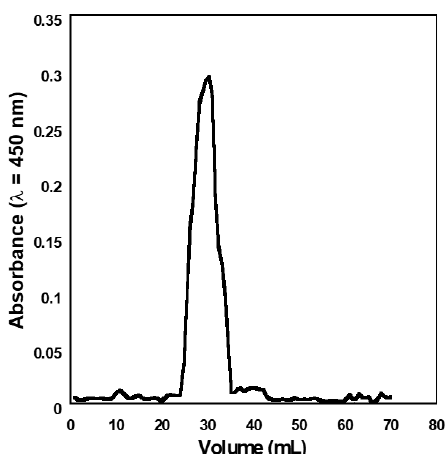
Figure 2. Low-pressure size exclusion chromatograms of the eluate fraction from the 30th to the 31st mL of the chromatogram reported in Figure 1a. By comparison with the behaviour of bovine albumin serum (molecular mass 66.5 kDa) and lysozyme from egg (molecular mass = 14.4 kDa), we infer that the HA solutions tested contain a population of molecules with hydrodynamic volumes ranging between these two extremes (Figure 3). It is worth noting that the humic acid sample analysed in this study, on the basis of recent studies of Li and coworkers [33], can easily be removed from aqueous solutions by adsorption on nanoscale zero-valent iron and magnetite.